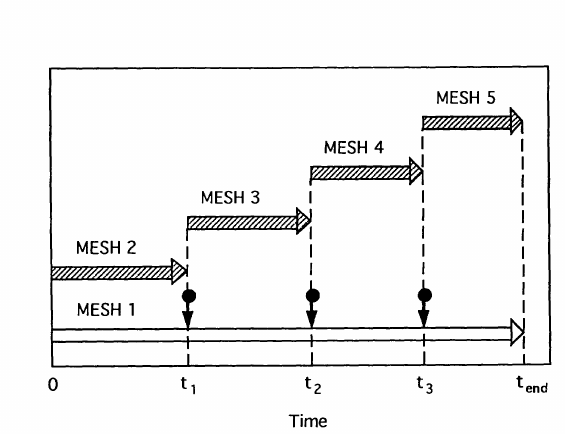
FIGURE 2 New adaptive procedure using initial coarse mesh run (Belytschko and Yeh,